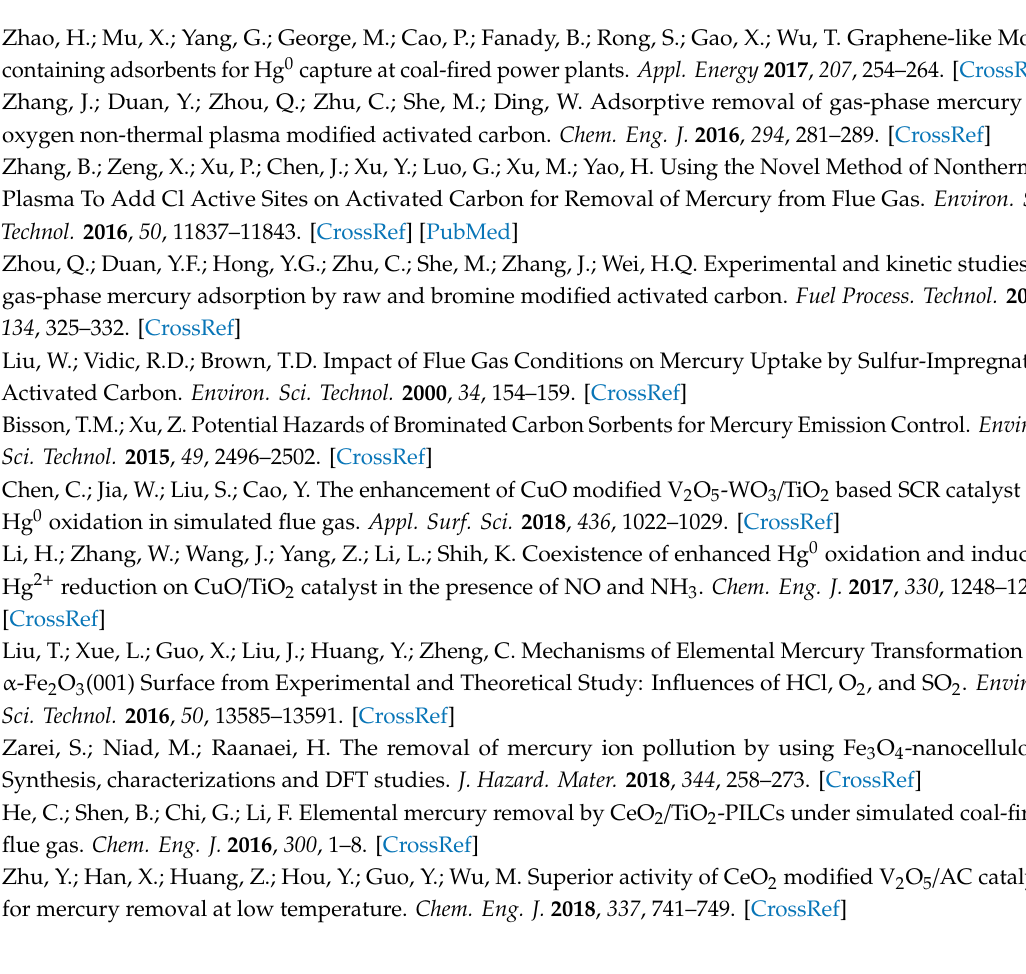
Figure S1: Outlet Hg 0 concentration without sorbent, Figure S2: The image of α MnO 2 -NR@TiO 2 after adsorption, Figure S3: Breakthrough curve of α MnO 2 -NR@TiO 2 with di ff erent Hg 0 feed concentration, Table S1: Comparison of the adsorption capacities of the